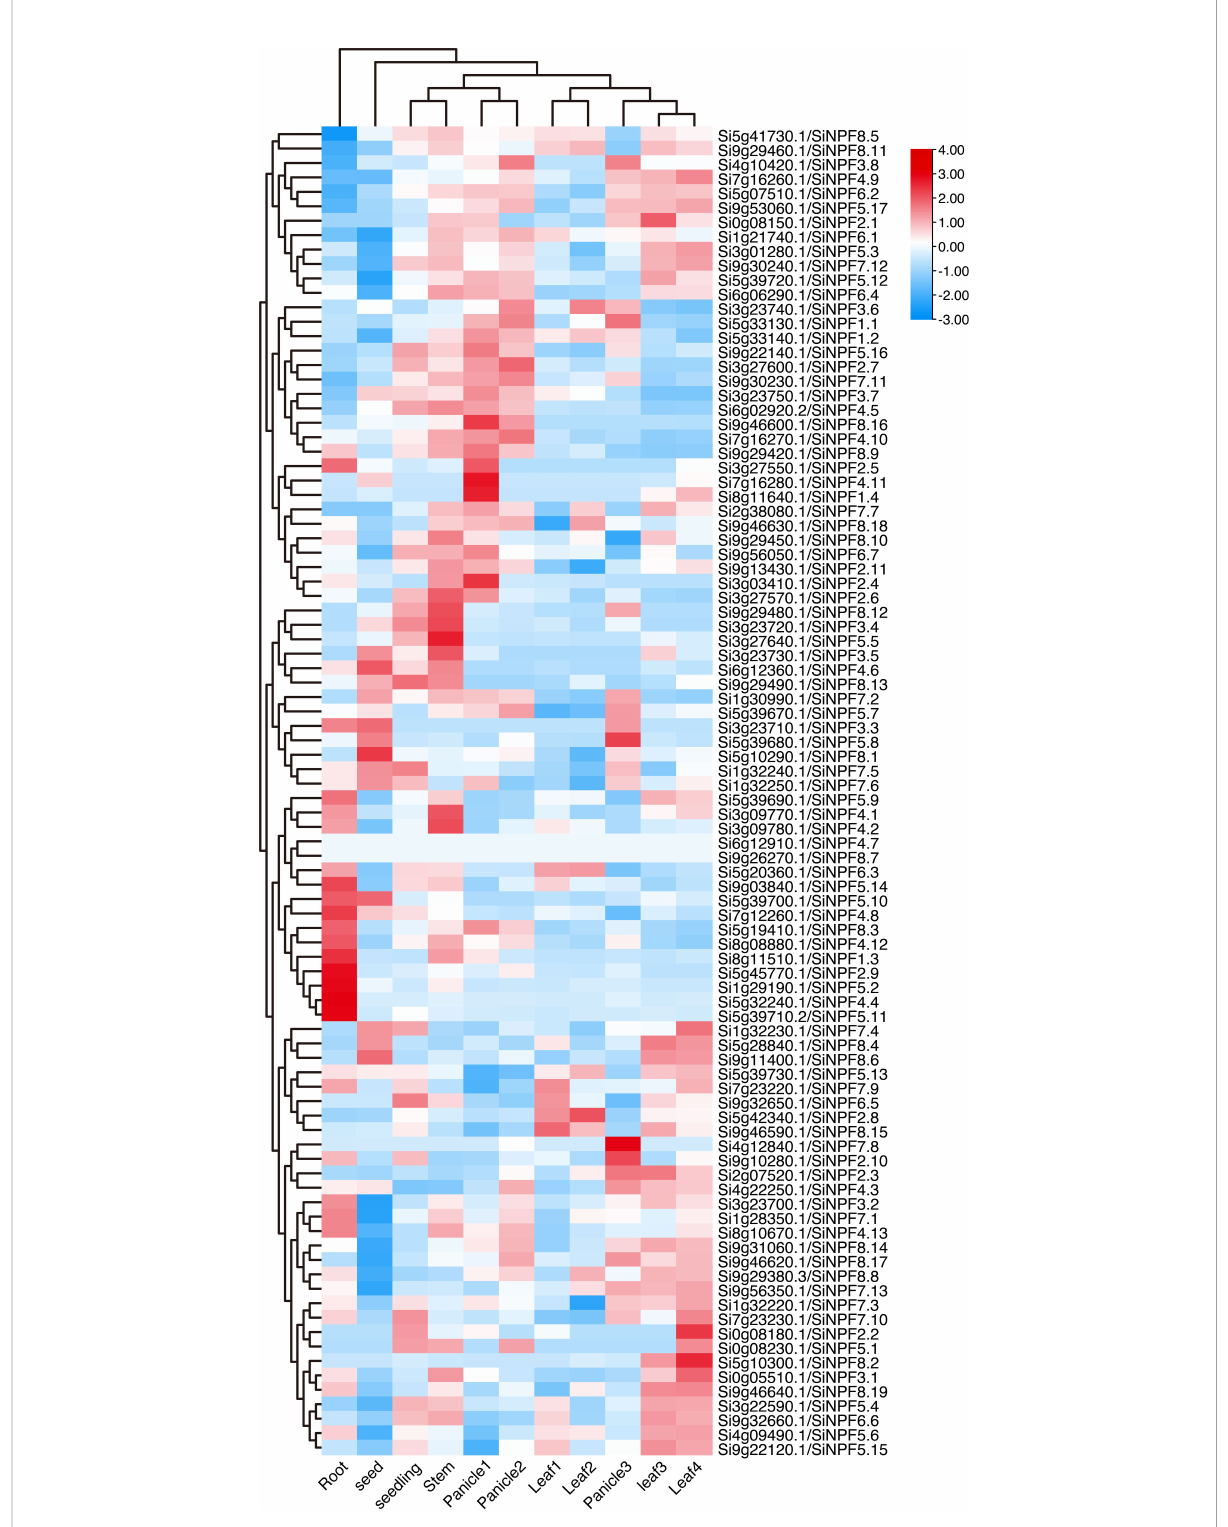
FIGURE 5 Gene expression atlas of the SiNPFs across eleven diverse tissues. 3 d imbibed seeds (seed), 2-week-old whole seedling (seedling), root, stem, the top fi rst fully extended leaf of 2-week-old seedling (leaf 1), the top second leaf of 30-day-old plants (leaf 2), fl ag leaf (leaf 3), the fourth leaf (leaf 4), immature panicle (panicle 1), panicle at pollination stage (panicle 2) and panicle at grain- fi lling stage (panicle